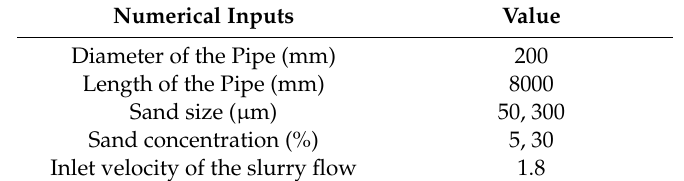
Table 3. Detailed inputs for the numerical simulation of sand transport and deposition.